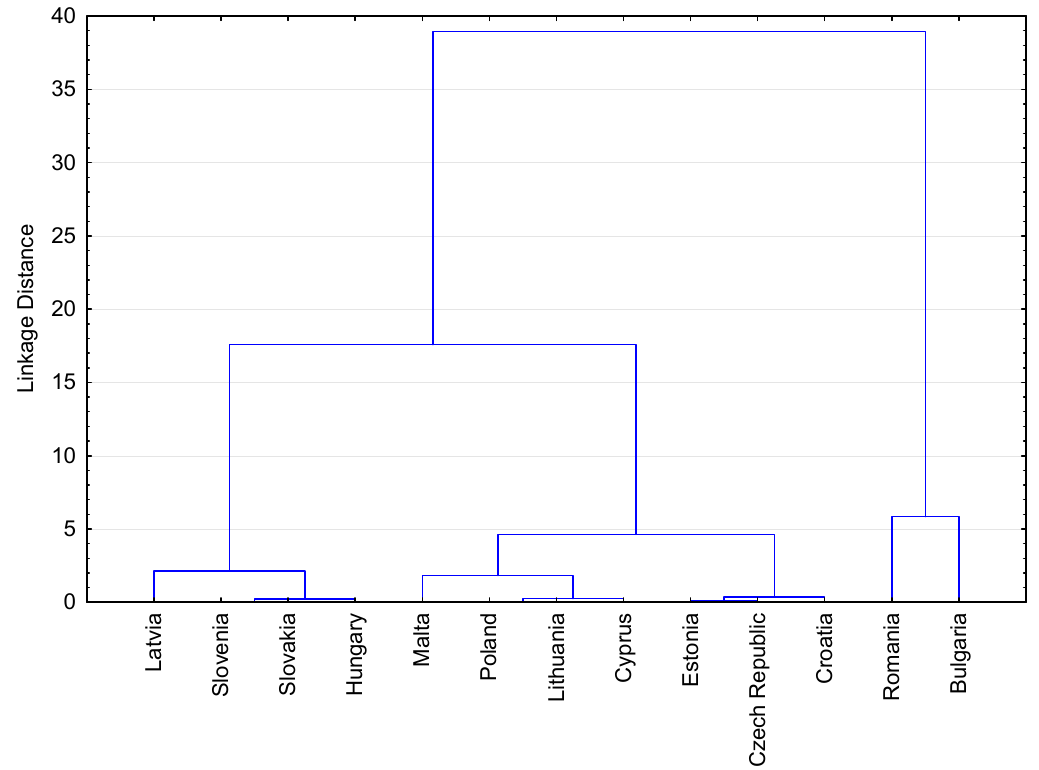
Figure 13. Tree diagram for IREN in 2016.